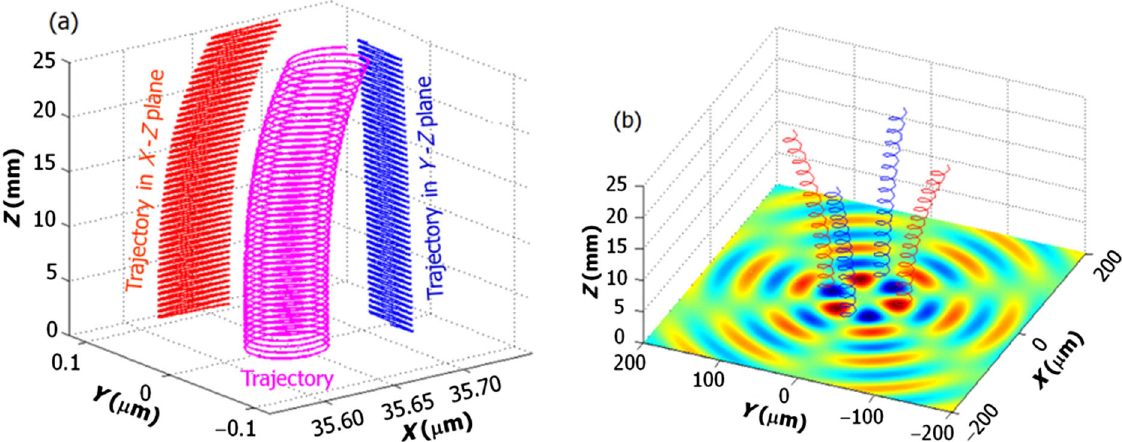
FIG. 2. Tracking result of electron trajectory (a), and the defocus effect (b), with the zoomed beam trajectory for a clear view, and with the electrical field rotating counterclockwise in the bottom.